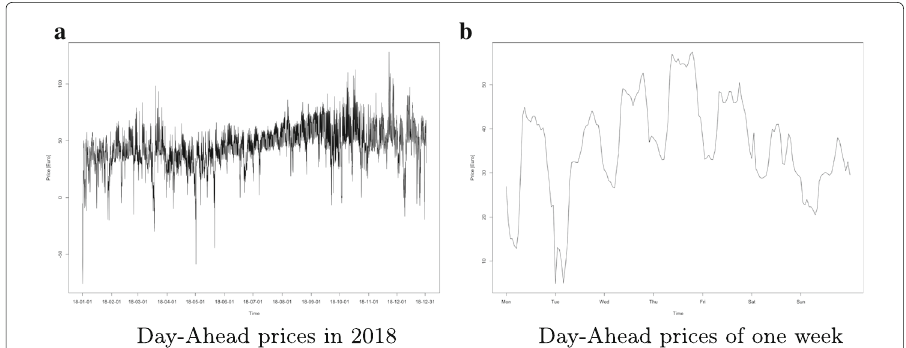
Fig. 2 Volatility of energy prices. a Day-Ahead prices in 2018. b Day-Ahead prices of one